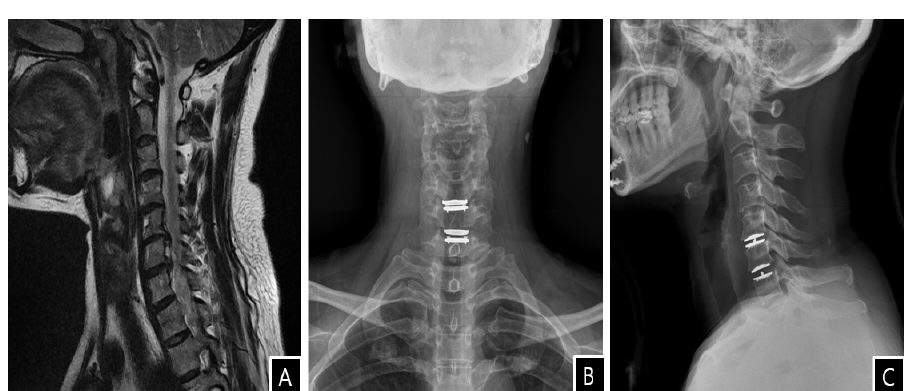
Figure 1. ( A ) T2-weighted sagittal magnetic resonance image reveals foraminal stenosis at the